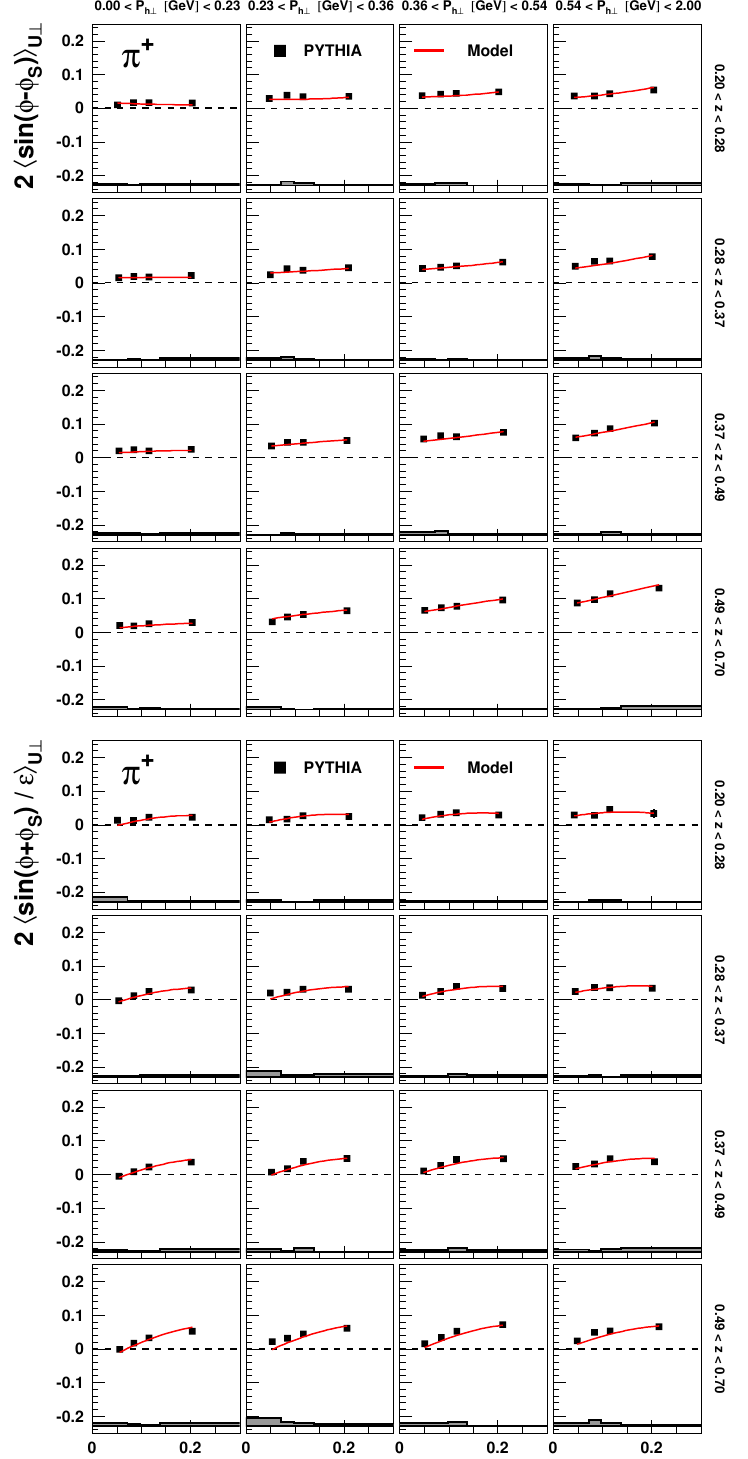
Figure 49 . Comparison of the Sivers (top) and Collins (bottom) asymmetries extracted from the “polarized Pythia6.2 ” simulation in the HERMES acceptance with the respective input param- eterizations evaluated at the average kinematics of each data point. The difference is assigned as systematic uncertainty and shown as uncertainty bands at the bottom of each